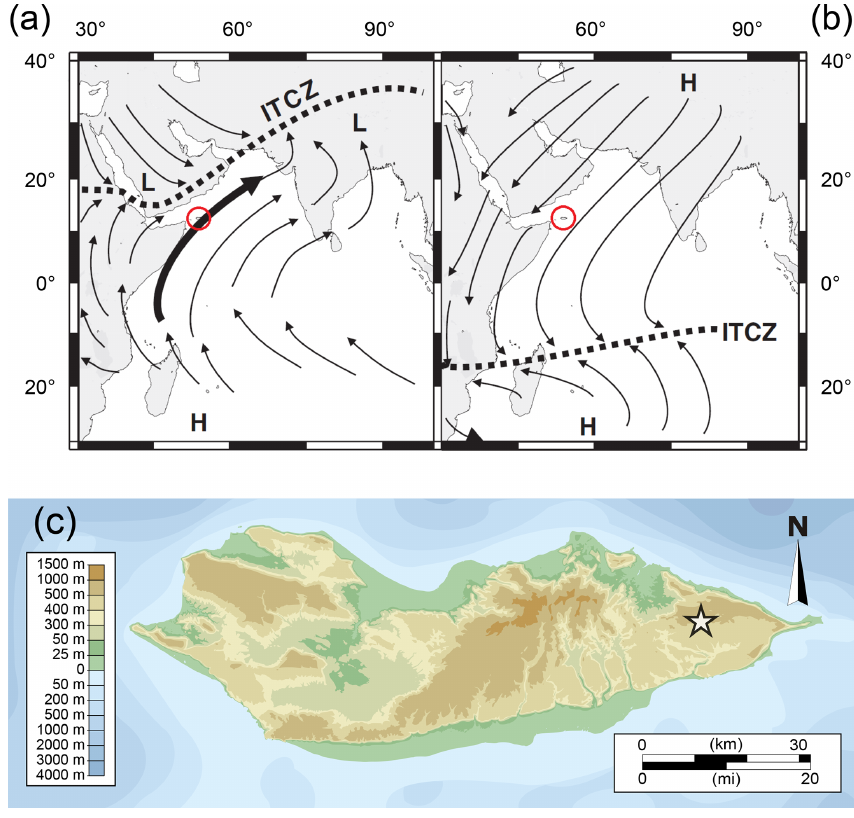
Figure 1. Upper figures show the geographic position of the Socotra archipelago (red circle) in the western Arabian Sea, east of the coast of Somalia with the prevailing monsoonal surface wind patterns in boreal summer (a) and boreal winter (b) relative to the Intertropical Convergence Zone (ITCZ) (graphic adapted from Fleitmann et al., 2007). In a topographic map (c) , the position of Moomi Cave in the east of Socotra Island on the Moomi Plateau is indicated by a white